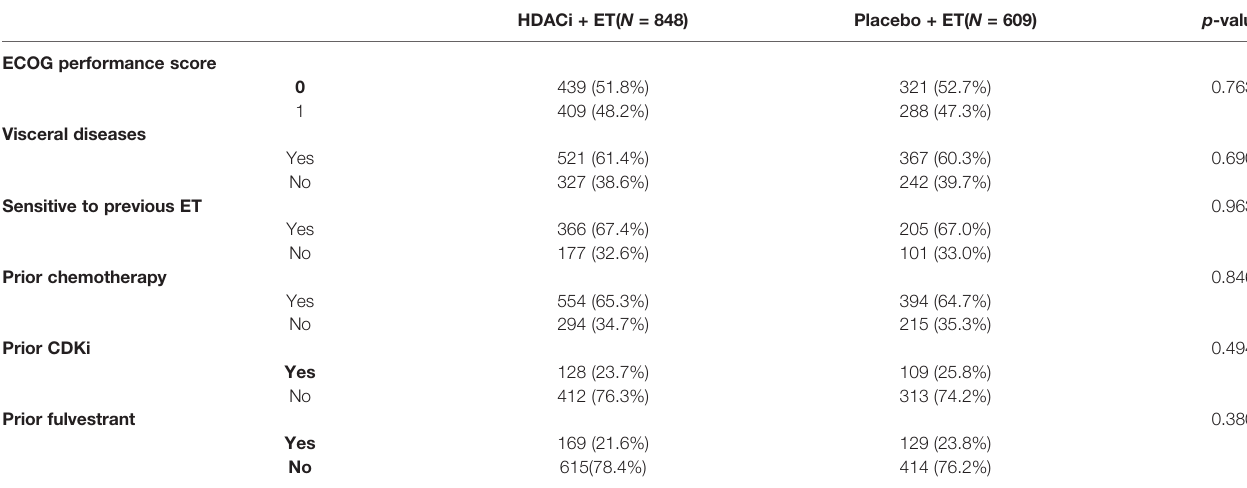
TABLE 2 | Demographic and clinicopathological characteristics of the study population.